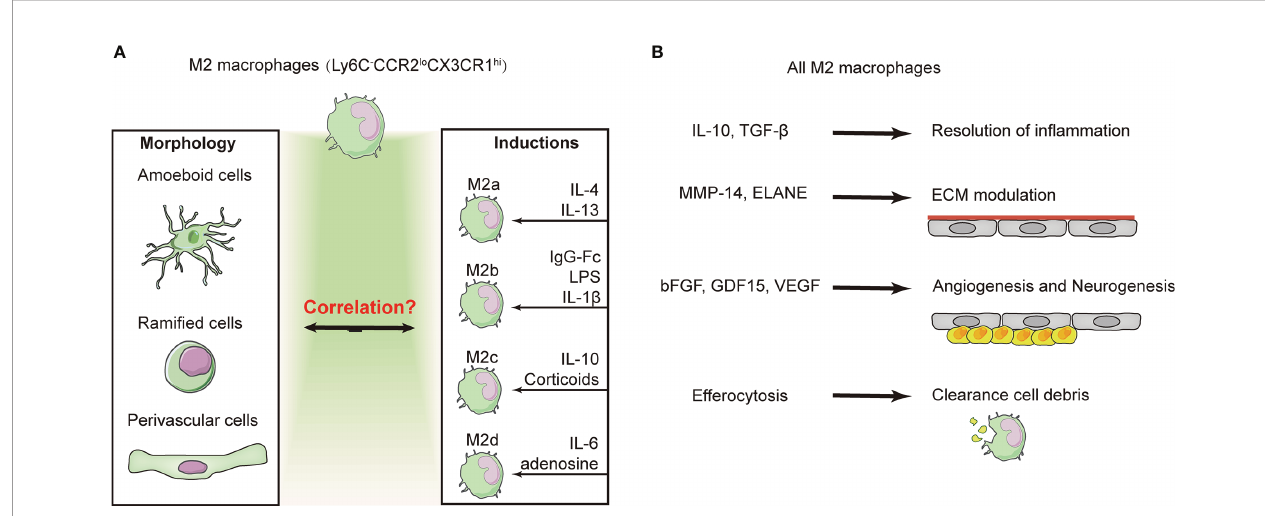
FIGURE 3 | Subtype conversion and function of M2 macrophages. (A) Majority of the macrophages exhibit the “ alternative/non-classic ” subtype (Ly6C − CCR2 lo CX3CR1 hi ) and are characterized as anti-in fl ammatory at several weeks after ischemic stroke. M2 macrophages exhibit three distinct phenotypes based on their morphology. However, based on the inducers and a consensus collection of markers, M2 macrophages can be divided into four subtypes. The identi fi cation of macrophages by morphological or cellular markers remains contentious and confusing. (B) Despite the confusion of macrophage identi fi cation, overall M2 macrophages have been shown to contribute to the resolution of in fl ammation, efferocytosis, and